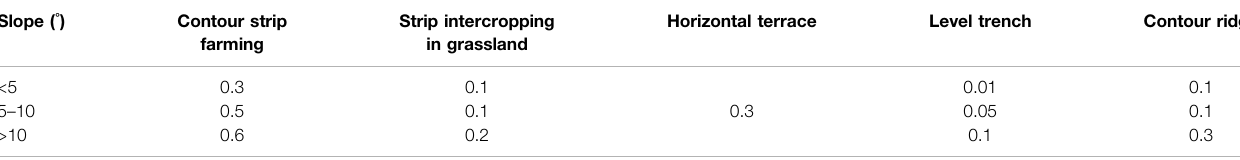
TABLE 2 | P value adopted under different soil and water conservation measures in China. Slope ( ° )